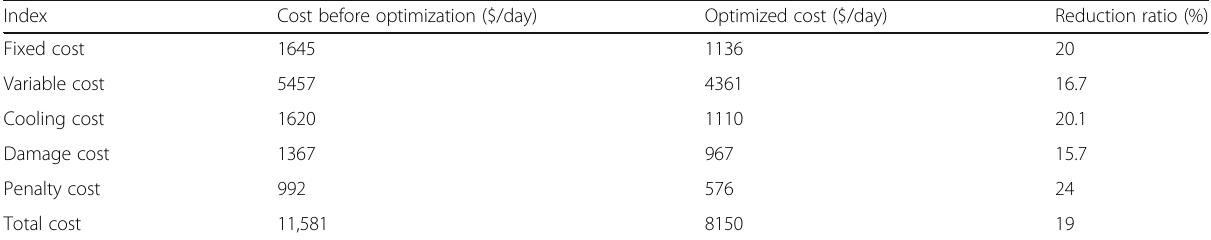
Table 1 Comparison of optimization results